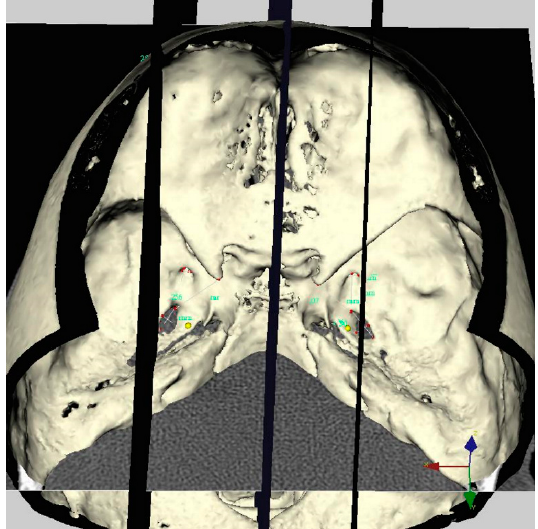
Figure 3. Three-dimensional representation of a TN patient’s skull. No intersection was found on the left side between the supraorbital-infraorbital foramen and impressio trigeminale. Examination of the trigeminal neuralgia patients revealed that there was more dis- tance between FOS-FR and FOS-FO than control patients (Table 3). Besides, the distance between the FOS-posterior clinoid and FR-posterior clinoid is higher than in normal pa- tients (Table 4). Table 3. The distances between the superior orbital fissure, rotundum, and ovale foramen in tri- geminal neuralgia patients and control subjects. The same letters indicate statistical significance which is less than 0.05.